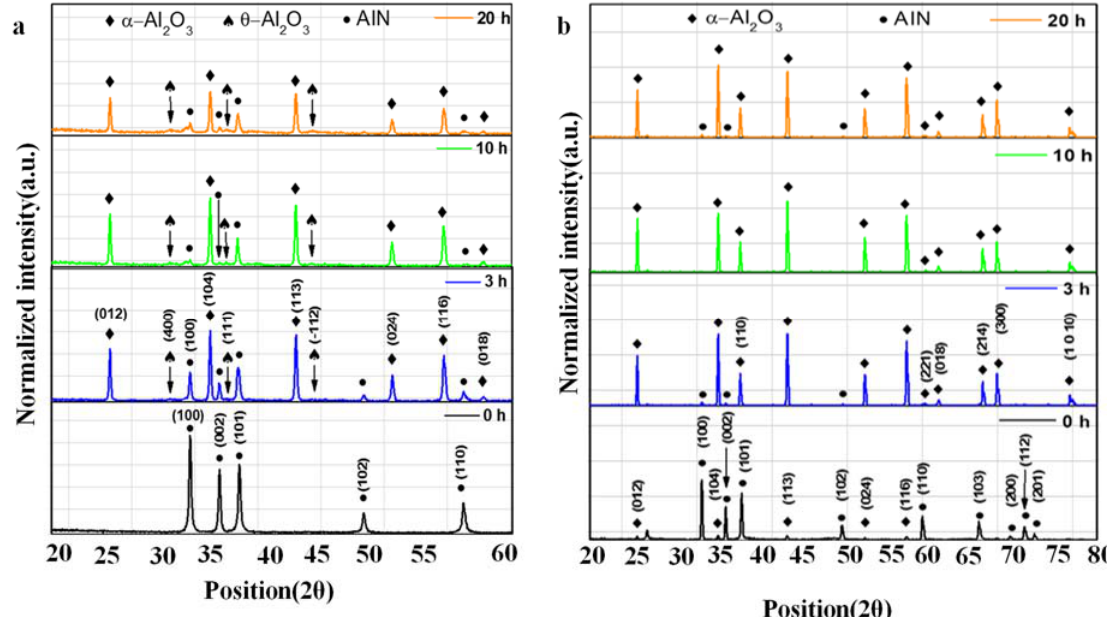
Figure 5. XRD diffractograms of both oxidized powders ( a ) and sintered samples ( b ). Oxidation has resulted in the conversion of pure AlN (at 0 h) to two distinct phases of aluminum oxide namely α -Al 2 O 3 and θ -Al 2 O 3 (at 3, 10, and 20 h) in ( a ). The sintered samples on the other hand show presence of only α -Al 2 O 3 besides AlN, proving that the sintering results in disintegration of θ -Al 2 O 3 phase.